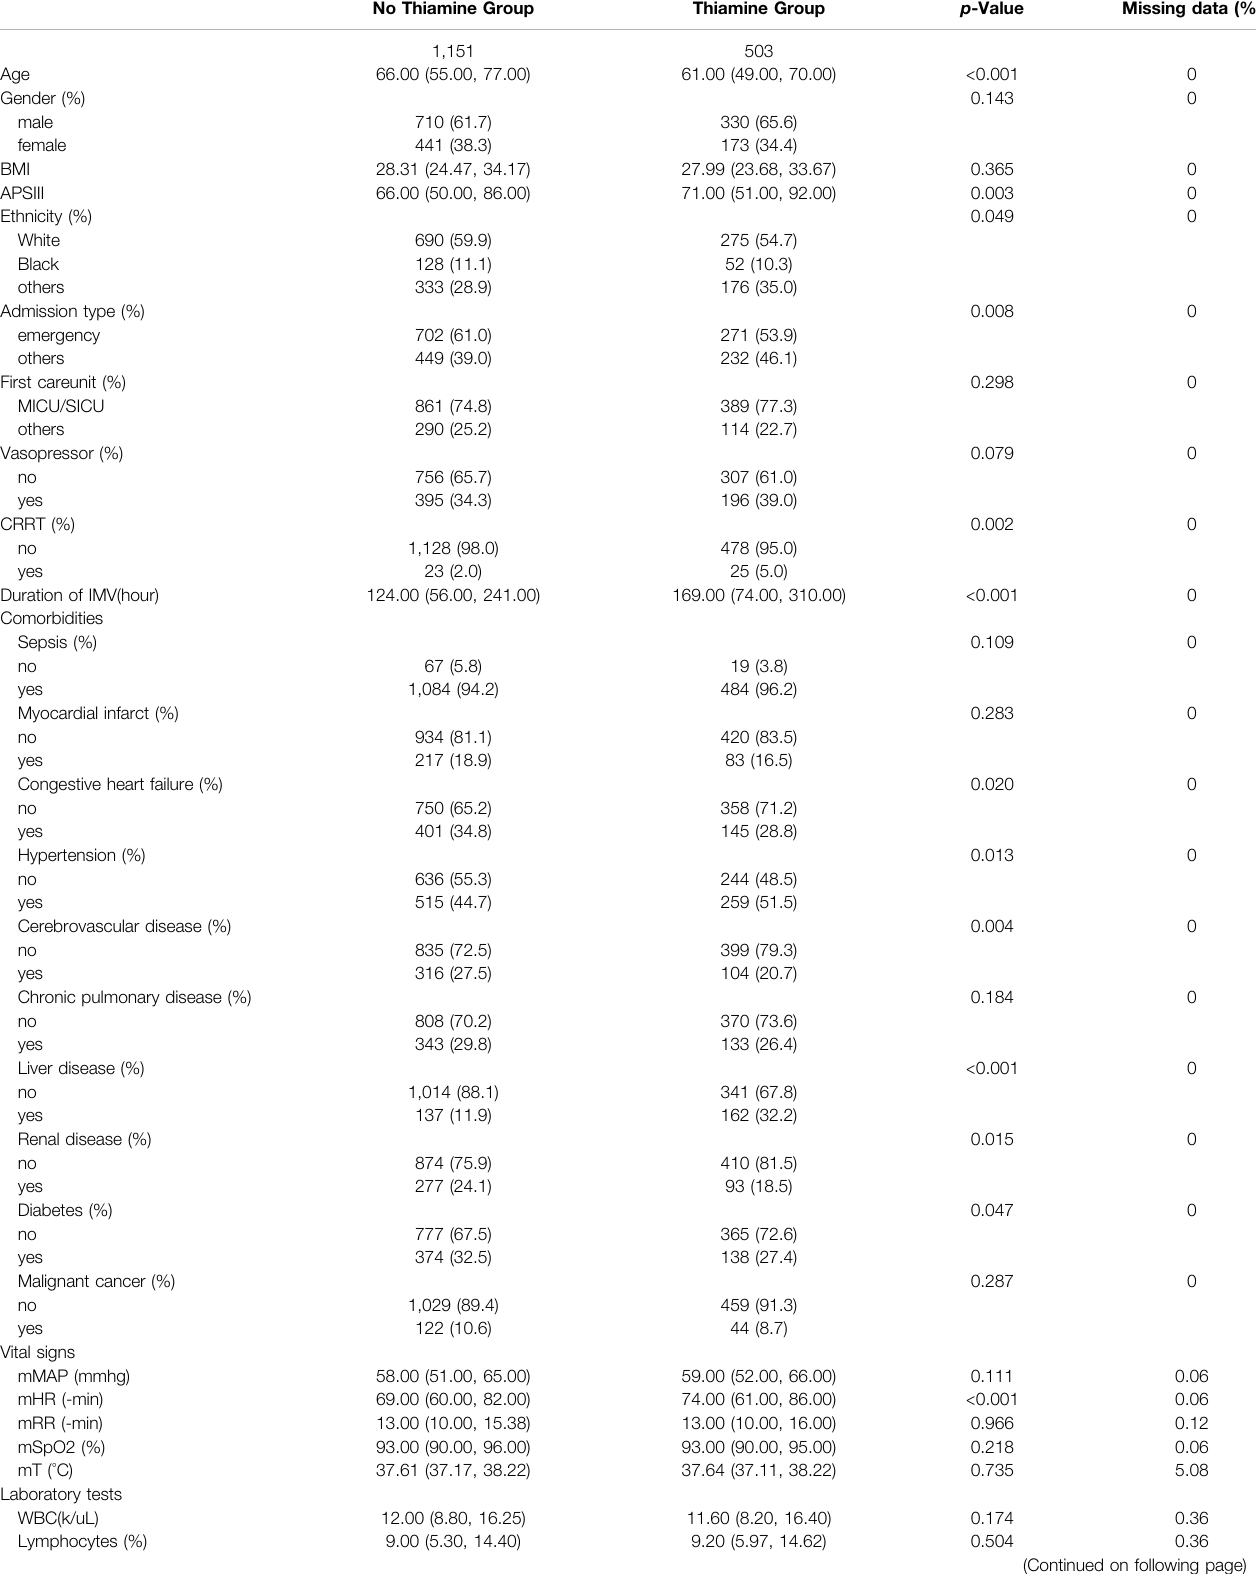
TABLE 1 | Baseline characteristics of the original